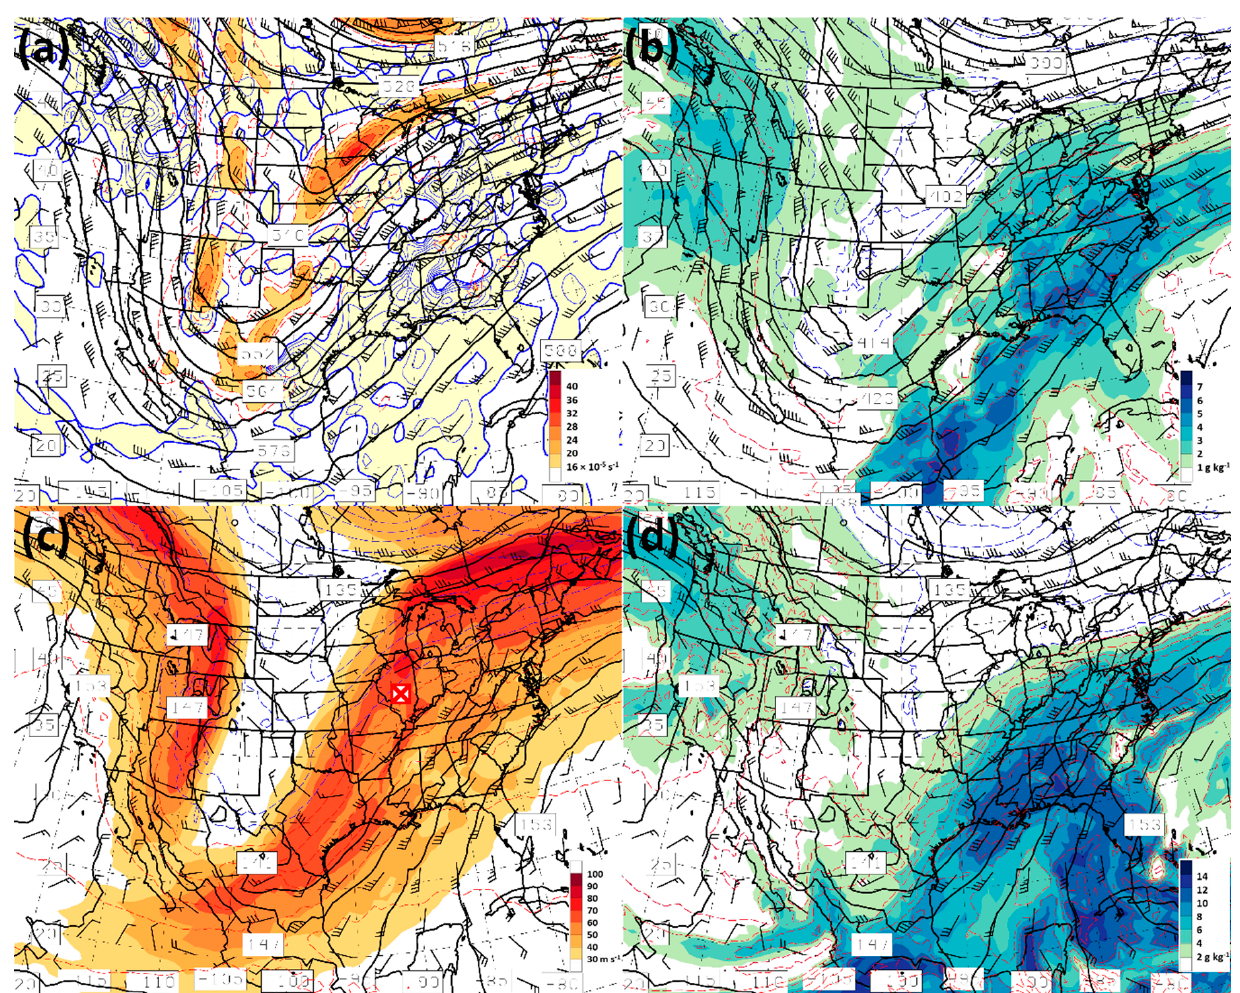
Figure 5. As in Figure 3, except GFS − analyzed fields valid at 0000 UTC 6 February 2020 of: ( a ) 500 hPa level geopotential height (dam, solid black contours), absolute vorticity × 10 − 5 (s − 1 , shading and red dashed contours), and wind vectors (kt) and 700 hPa level rising motion × 10 − 3 (hPa s − 1 , vanilla shading and blue solid contours); ( b ) 600 hPa level geopotential height (dam, solid black contours), mixing ratio (g kg − 1 , shading), equivalent potential temperature (K, final blue (first red) dashed contour value is 304 K (310 K)), and wind vectors (kt); ( c ) 850 hPa level geopotential height (dam, solid black contours) and wind vectors (kt) and 1000–500 hPa layer thickness (dam, final blue (first red) dashed contour value is 540 dam (546 dam)), and 300 hPa level wind speed (m s − 1 , shading); and ( d ) 850 hPa level geopotential height (dam, solid black contours), mixing ratio (g kg − 1 , shading), wind vectors (kt), and equivalent potential temperature (K, final blue (first red) dashed contour value is 280 K (286 K)). Red cross-square symbol in panel ( c ) represents the locally dominant 850 hPa level cyclone center.